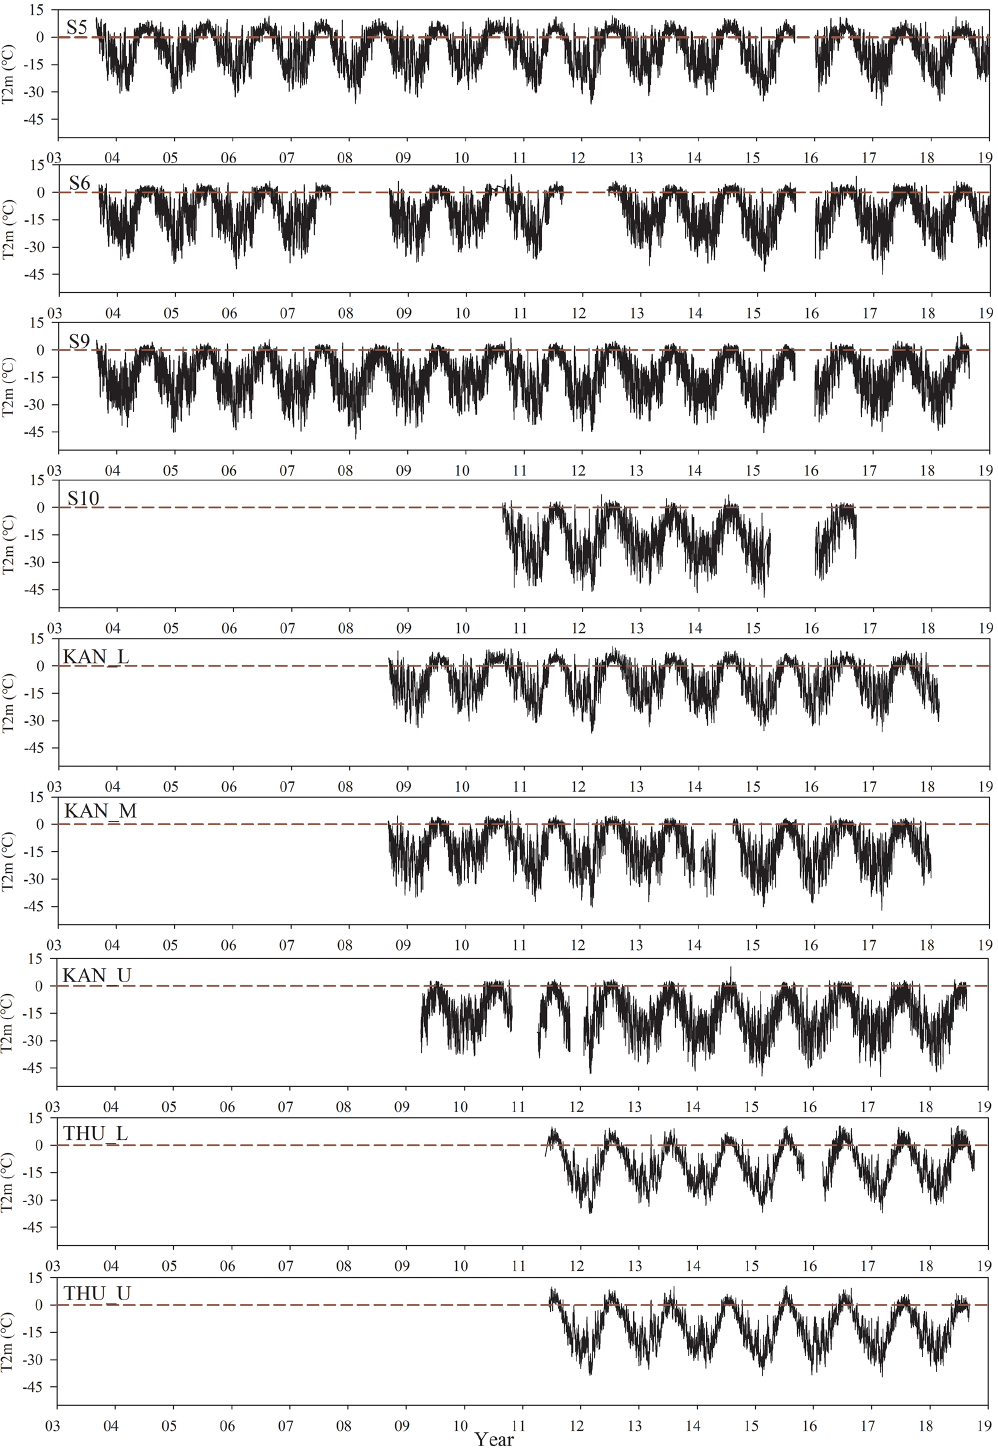
Figure 2. Time series of 2m temperature ( T 2m ) at the nine AWS sites used in this study.